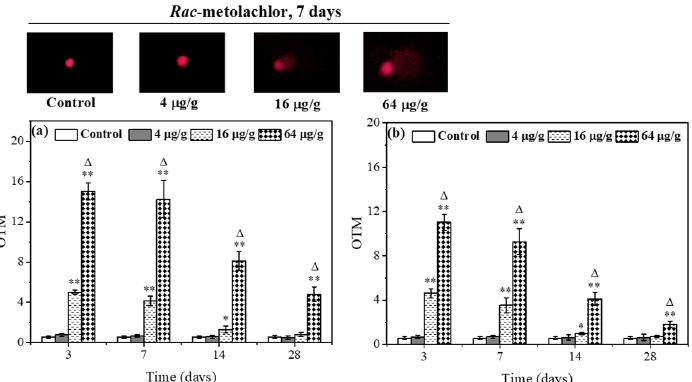
Figure 4. Effects of Rac - ( a ) and S -metolachlor ( b ) on DNA damage in E. fetida . * p < 0.05 and ** p < 0.01 indicate the statistical significance between the control group and treatment group at the same exposure time. “Δ” represents a significant difference between Rac - and S -metolachlor treatment groups at the same exposure concentration ( p < 0.05).